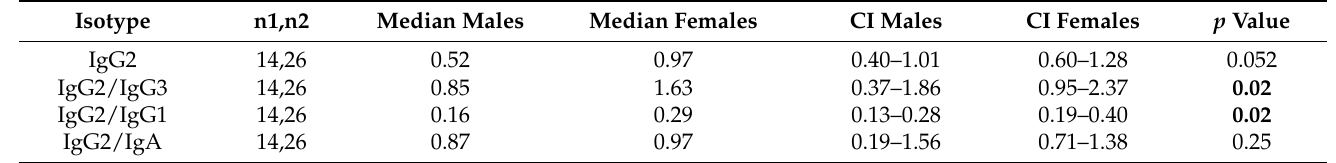
Table 7. Higher preference for IgG2 in females compared to males in the FluVIT human study.